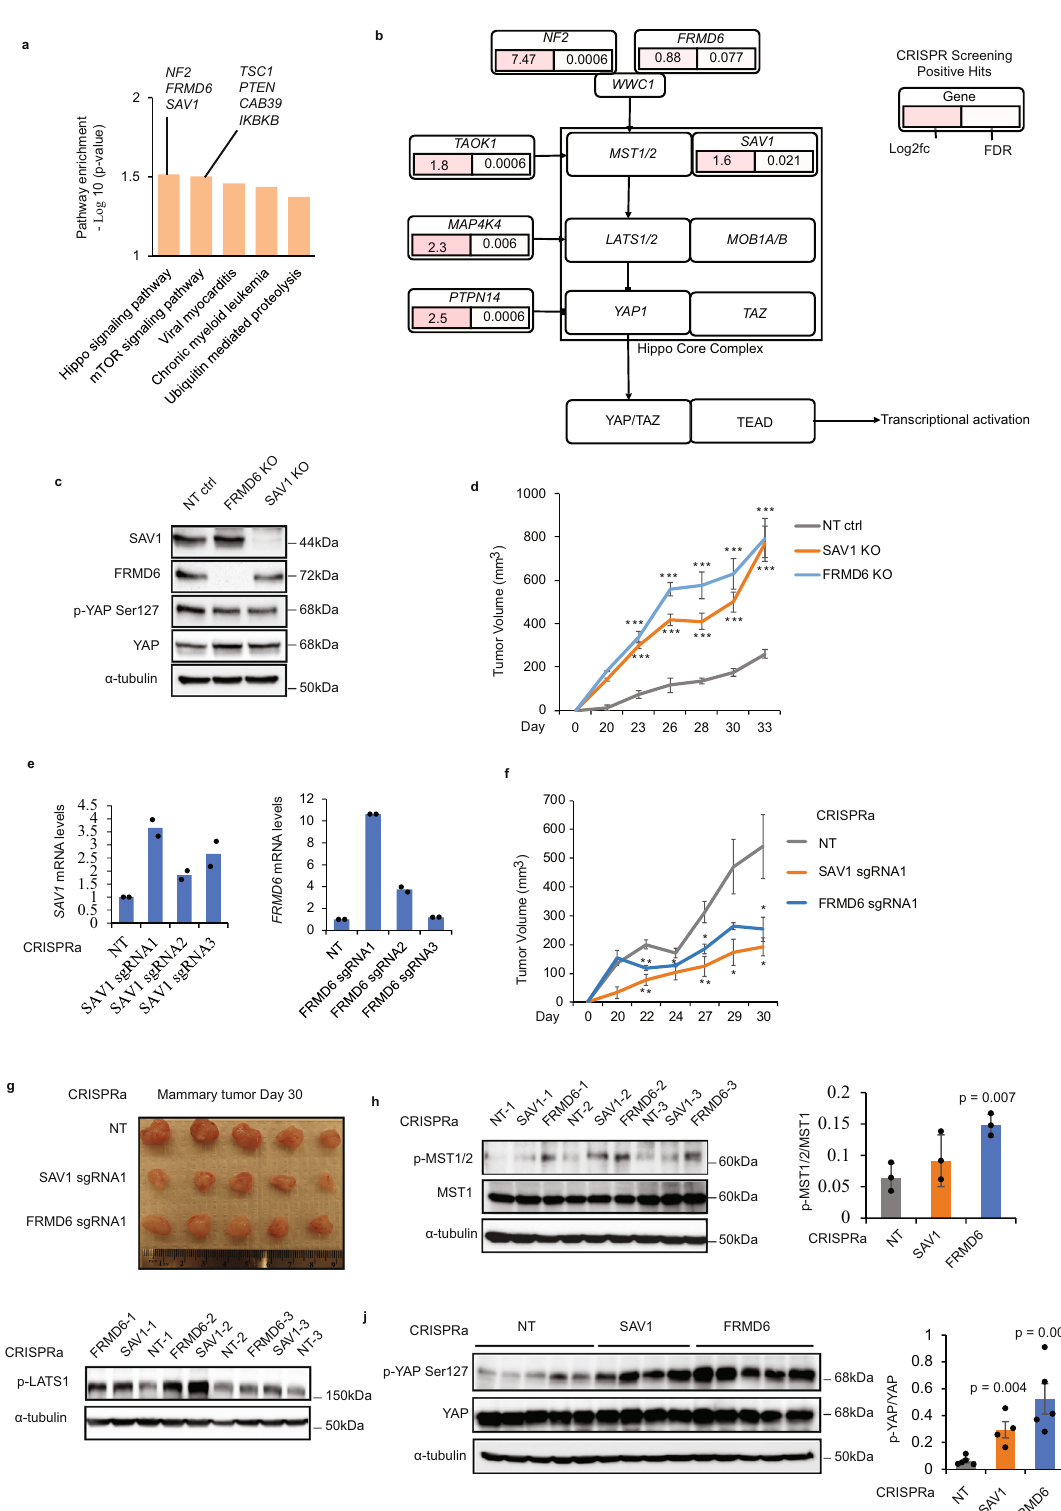
Torin1 enhances vertepor fi n-induced apoptosis in TNBC . We which torin1 and vertepor fi n relay their tumor-suppressive effects death and survival. As shown in Fig. 6a, both torin1 and